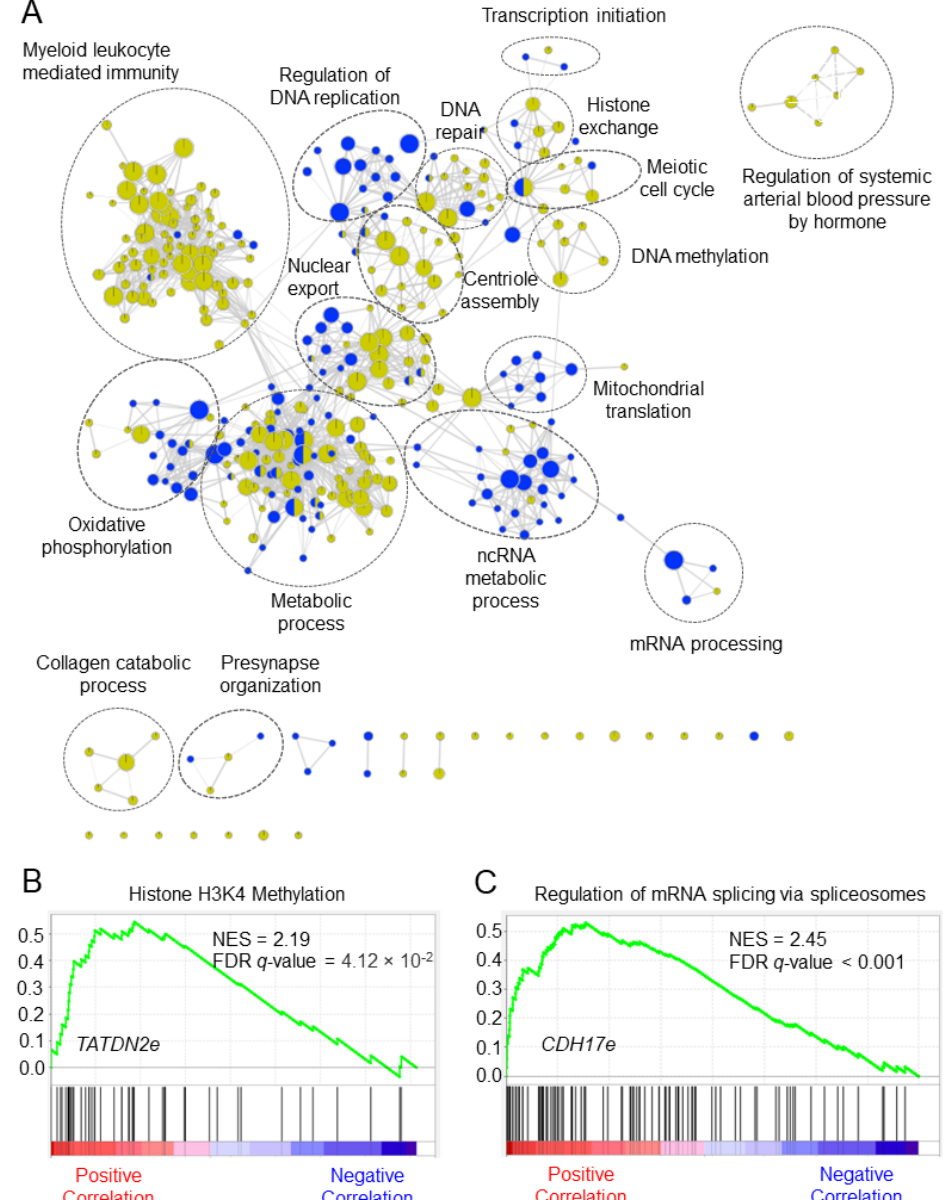
Figure 7. Putative biological functions of the enhancer RNA signature in colorectal cancer. ( A ) The network shows overrepresented gene sets for the signature. Green nodes represent gene sets en- riched in colon cancer, and blue nodes represent gene sets enriched in rectal cancer. Node size is proportional to the normalized enrichment score. Genes sets with similar biological functions tend to form clusters, these were manually identified, and gene ontology terms with the highest NES were labeled. ( B , C ) The enrichment plot shows the highest enriched function for TATDN2 - associated eRNA ( TATDN2e , ENSR00000148476) in colon cancer and CDH17 -associated eRNA ( CDH17e , ENSR00000227152). FDR = false discovery rate, NES = normalized enrichment